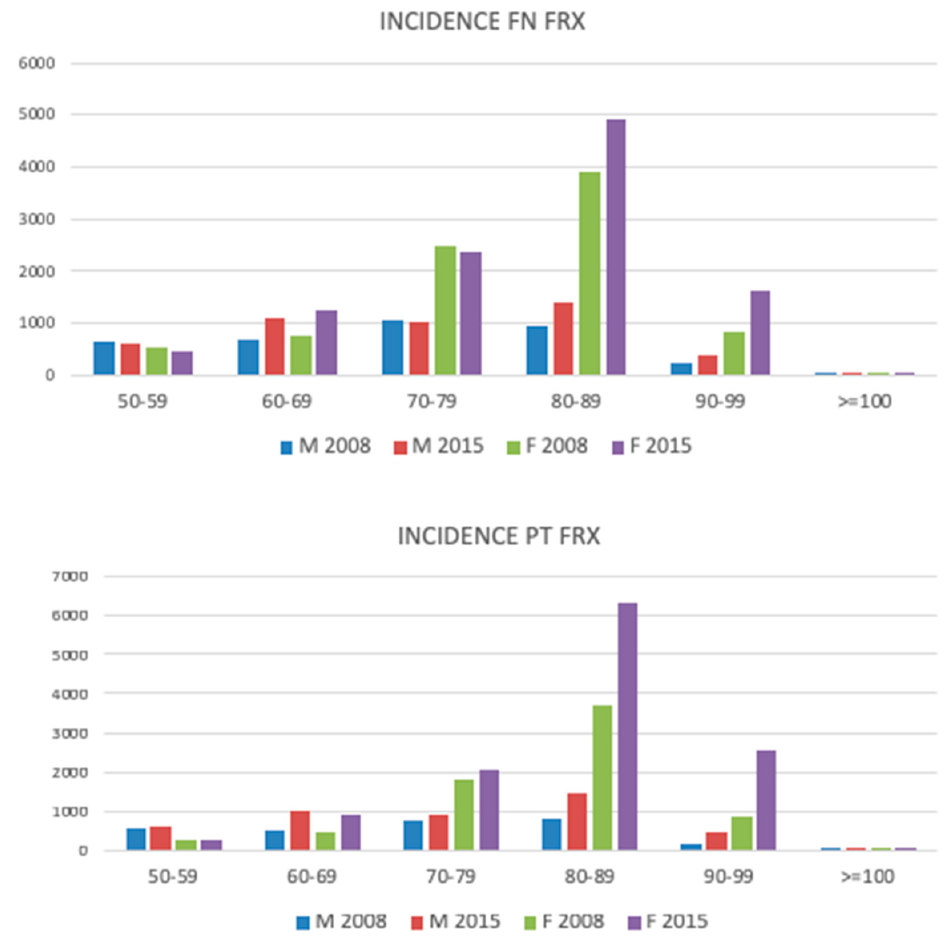
Figure 1. Incidence of the femoral neck (FN) and pertrochanteric (PT) fracture in different age groups, compared between men and women, in the years 2008 and 2015.